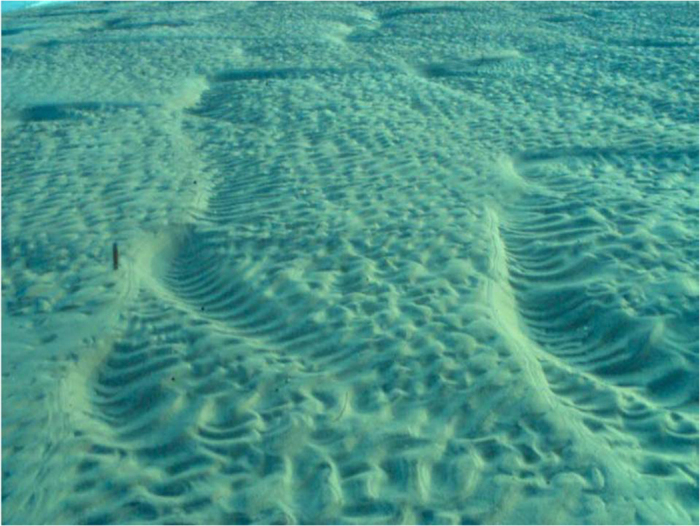
Ripples are the most common bedform type on the Earth’s surface.They occur on beaches, in rivers, on the seabed, in tidal intets and - as shown here - on a tidal flat of the Danish Wadden Sea where ripples are the dominating feature superimposed on small dunes. The rod on the left is 15 cm long. Photo, Jesper Bartholdy.